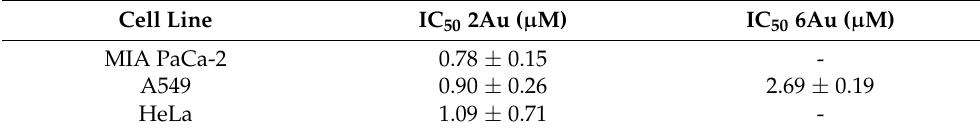
Table 5. IC 50 ( µ M) of 2Au and 6Au with HeLa, A549, and MIA PaCa-2 cell lines after 72h of